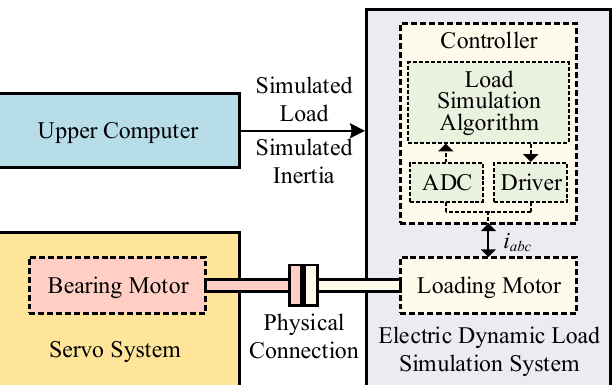
Figure 3. The inertia simulation structure.